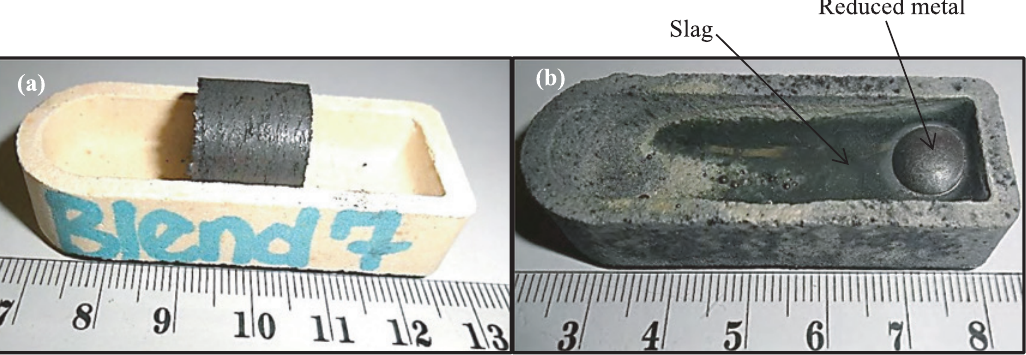
Fig. 3: Composite pellets (slag + Blend 7): a) before reduction and b) after reduction at 1500